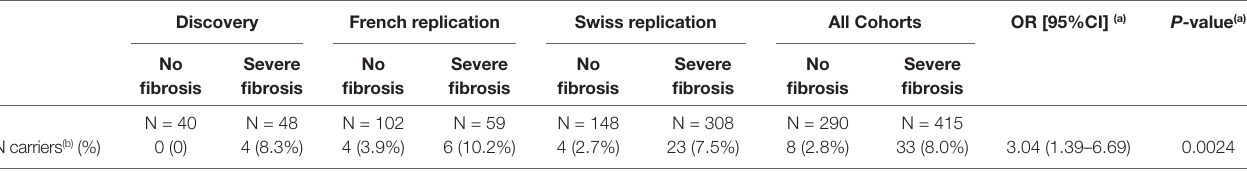
TABLE 2 | Distribution and overall effect of ENG Thr5Met on liver fibrosis progression in the discovery cohort and the French and Swiss replication cohorts. Discovery French